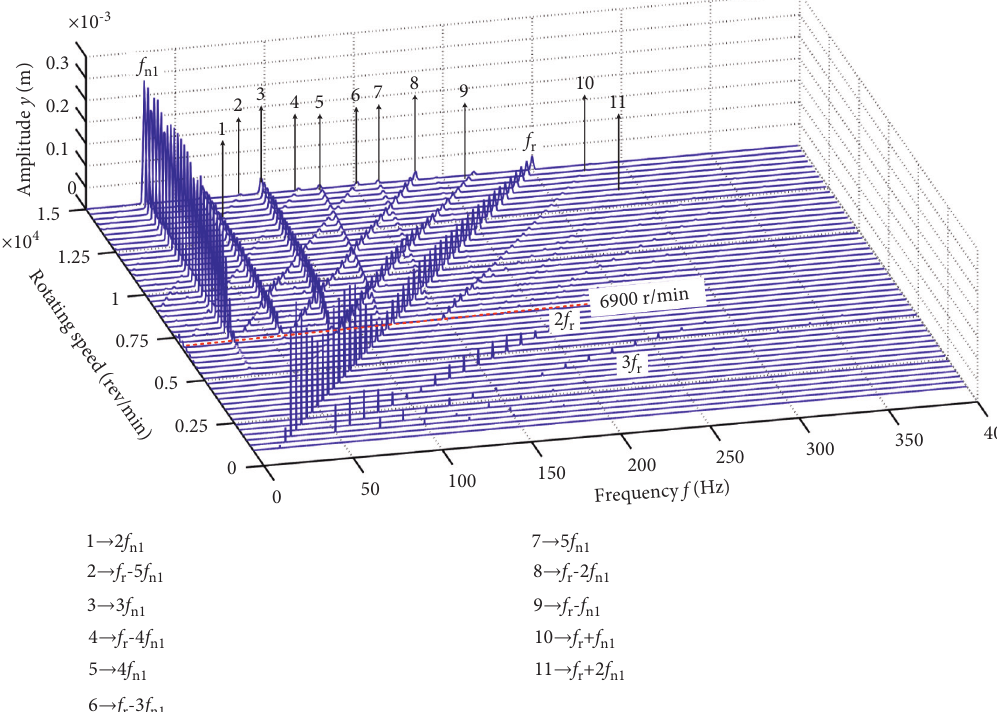
Figure 3: Spectrum cascade of the right journal.